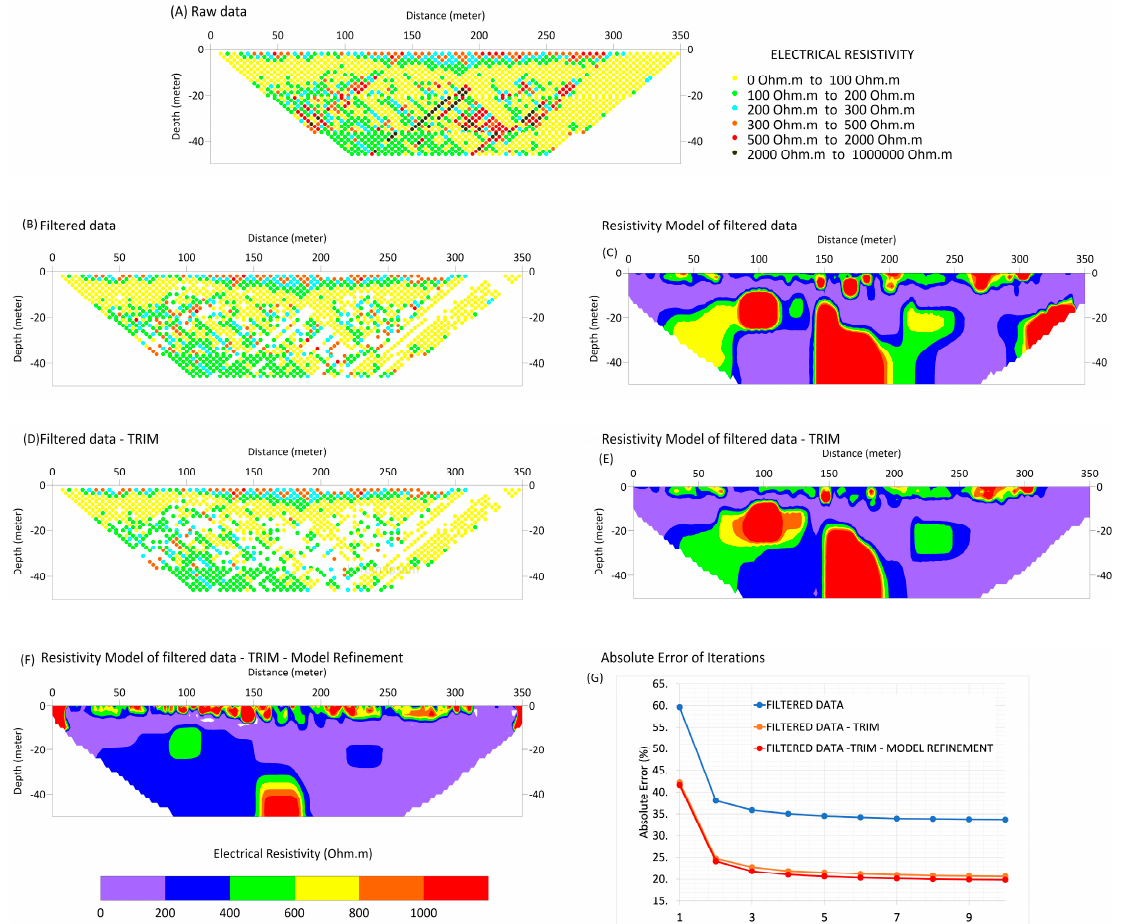
Figure 6. ERT data analysis along profile A - A’ : ( A ) raw data, ( B ) filtered data, ( C ) resistivity model of the filtered data, ( D ) filtered and trimmed data, ( E ) resistivity model of the filtered and trimmed data, ( F ) resistivity model refinement using the grid of cells of 2.5 × 2.5 m 2 , and ( G ) absolute errors values and the data sets with reference to the number of iterations.